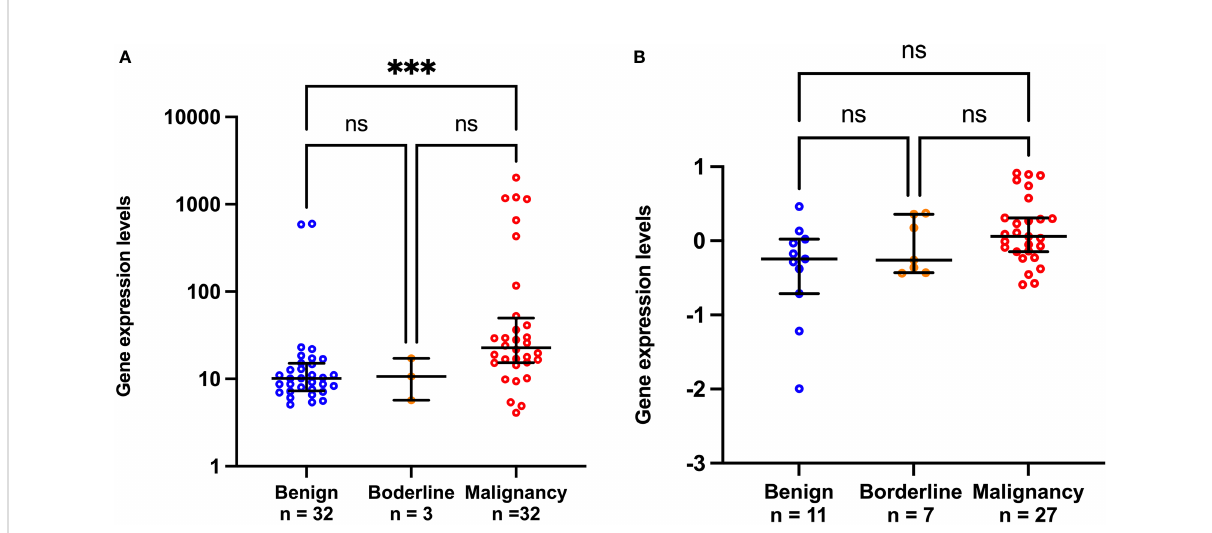
FIGURE 4 Scatter plots of CCL20 gene expression from public GSE4122 dataset (A) and GSE17308 dataset (B) . ***p<0.001; not signi fi cant (ns). The lower and upper whiskers are interquartile ranges, and the middle line is the